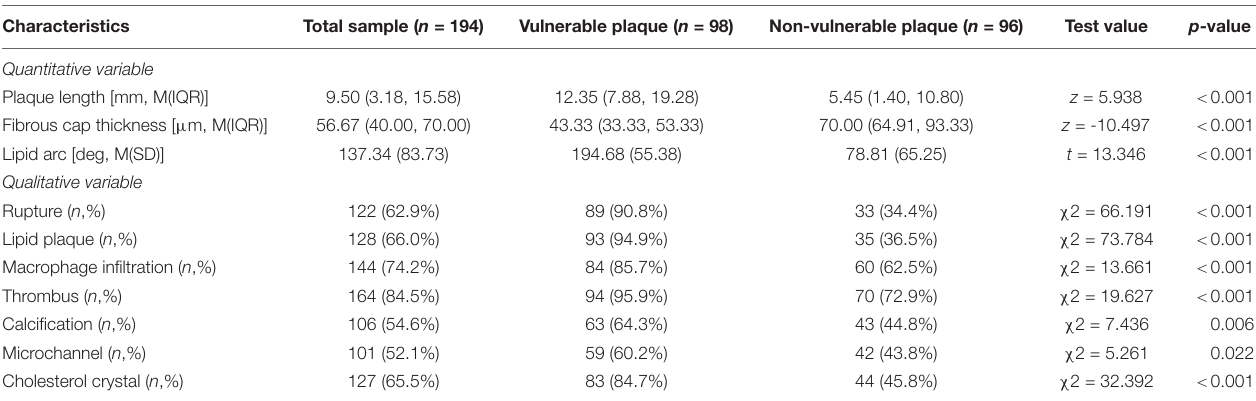
TABLE 2 | OCT characteristics of vulnerable plaque and non-vulnerable plaque individuals ( N =